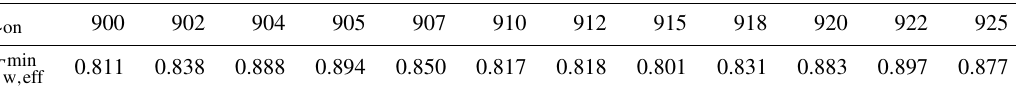
Table 3. Effective water vapor transmission at 10km height, T min spectrum (water vapor profile of 2 July 2015).